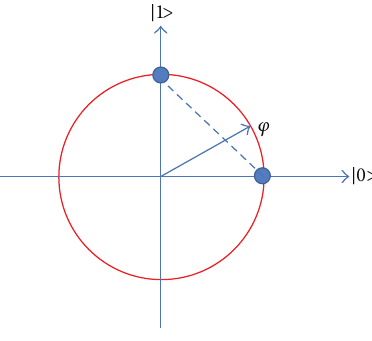
Figure 14: Qbit model in state: (1/√2)|0⟩ + (1/√2)|1⟩